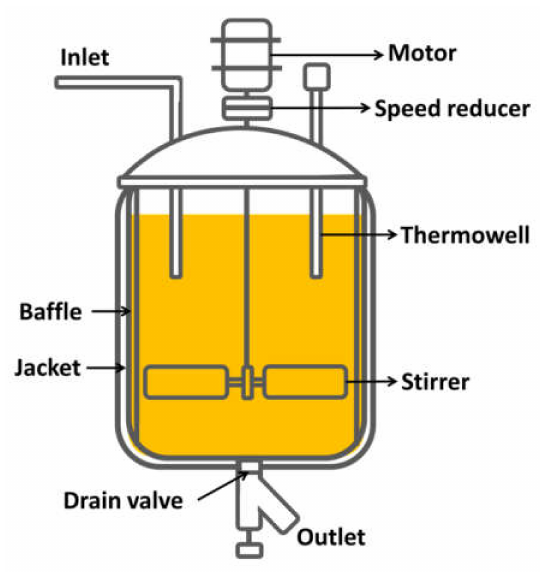
Figure 6. Main components of a continuous reactor. The equation for reaction design is obtained through a mass balance. Figure 7 shows the basis for the design of a continuous